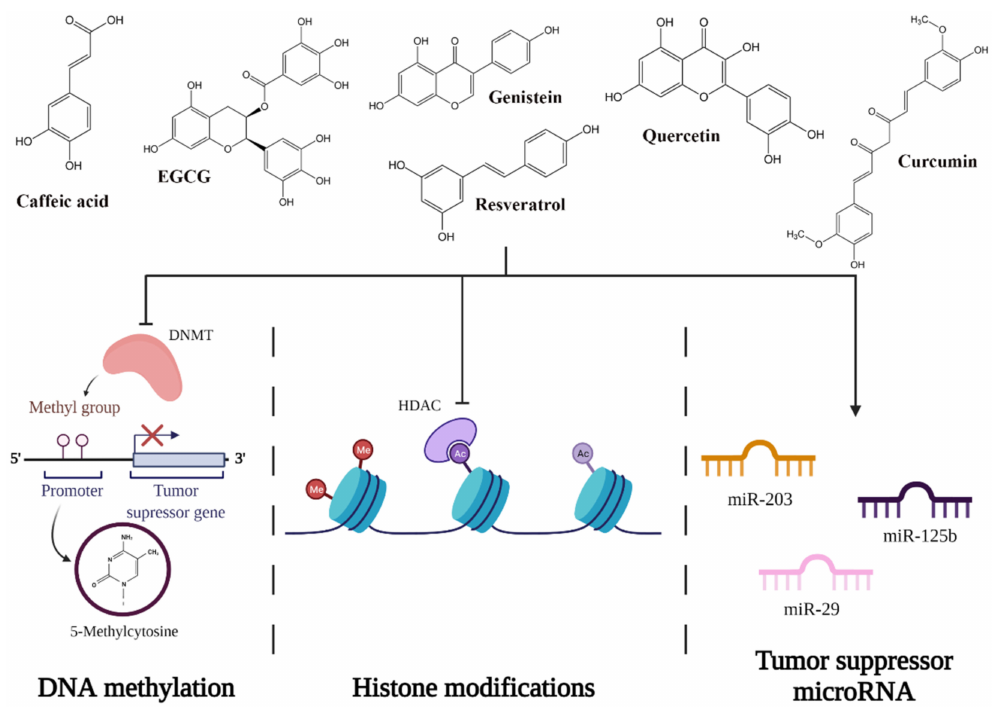
Figure 6. Potential mechanisms of action of polyphenols on epigenetic pathways. Non-Coding RNA: